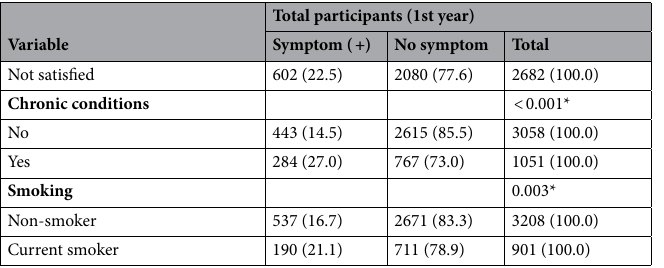
Table 1. General characteristics and the prevalence of depressive symptoms of the participants at baseline and the two-year follow up of the participants without depressive symptom.